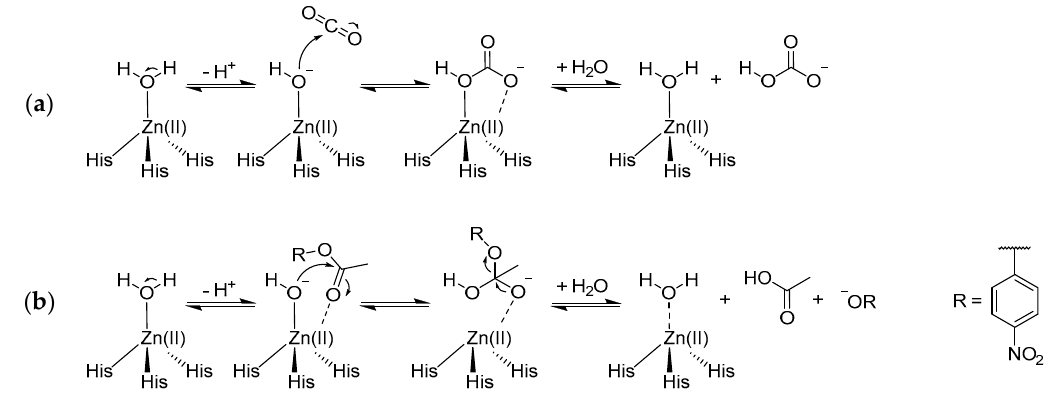
Scheme 1. Proposed reaction mechanisms of ( a ) CO 2 -hydration and ( b ) 4-nitrophenyl acetate (4-NPA) hydrolysis initiated by the nucleophilic Zn(II)-bound hydroxide [26].